Question: Write a descriptive caption for this figure.
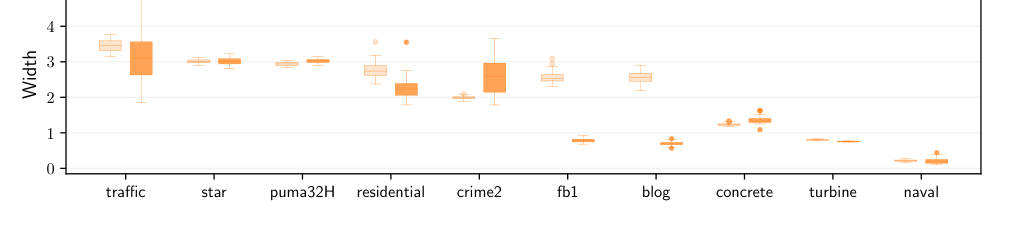
Answer: 6: Comparison of average interval lengths between conformalized models trained on 50% of the data and models trained on 75% of the data.